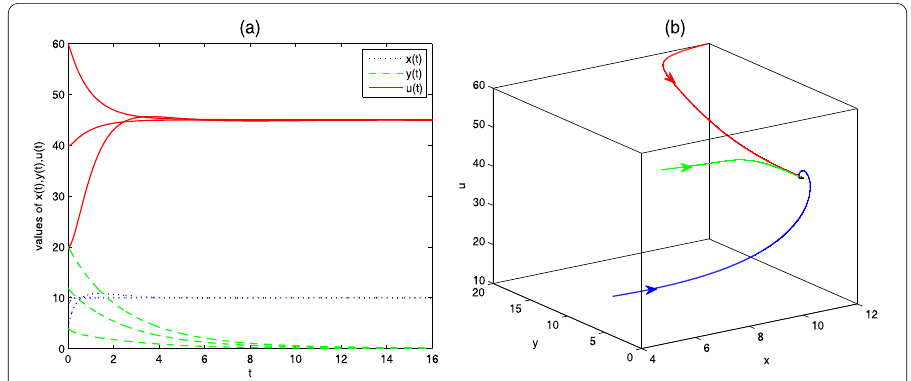
Figure 3 Global asymptotic stability of the predator-extinction equilibrium point E 1 for different initial values